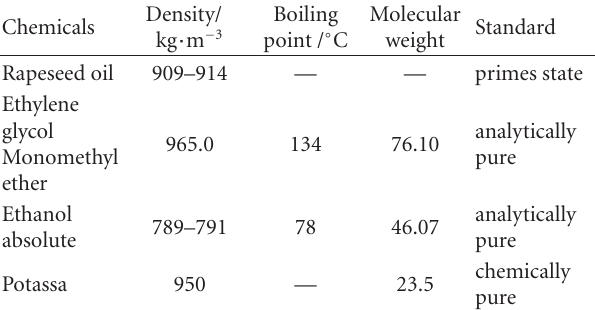
Table 1: Specification of the used chemicals.